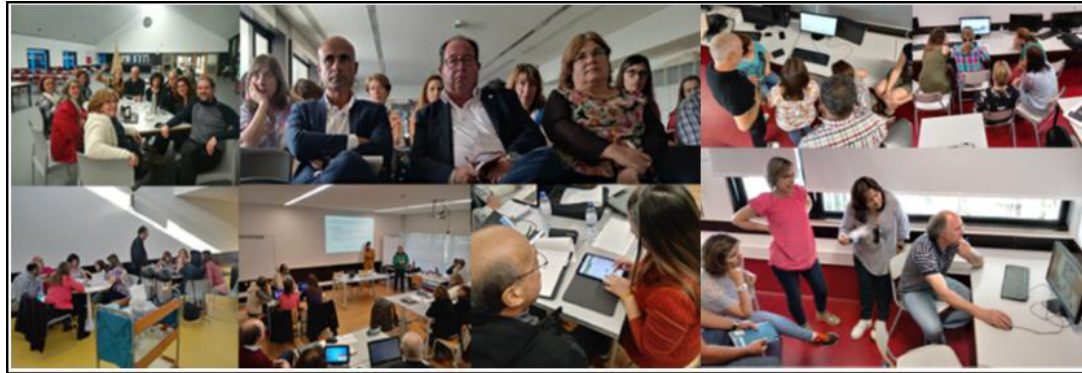
Figure 2. Smart School Workshops.